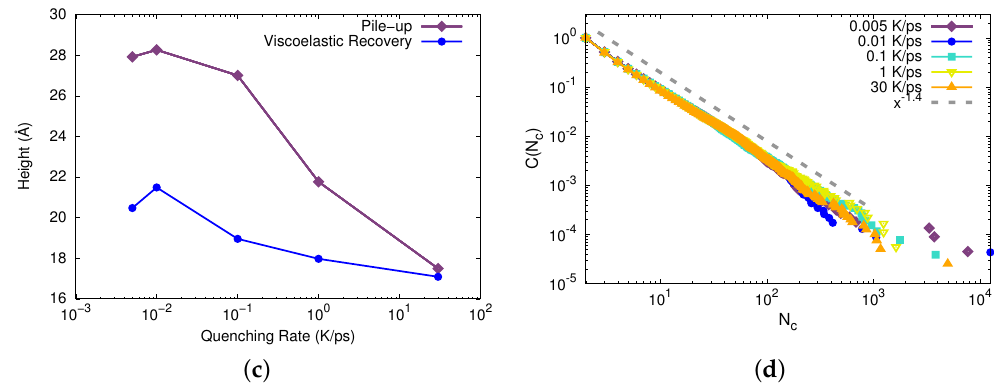
Figure A1. Quenching-rate dependence in nanoindentation; all data taken at 10 K. ( a ) Indentation load vs. indentation depth for various quenching rates. ( b ) Contact pressure as a function of indentation depth for the quenching rates shown in ( a ). Inset: Averaged hardness against indentation rate fitted to a power law with exponent ∼ − 0.02. ( c ) Pile-up height and viscoelastic recovery vs. quenching rate. Both quantities are measured after removal of the indenter. ( d ) Complementary cumulative distributions C ( N c ) for the quenching rates shown in ( a ). The distributions were calculated at maximum indentation depth 70 Å. The gray dashed line corresponds to a power law with exponent − 1.4.